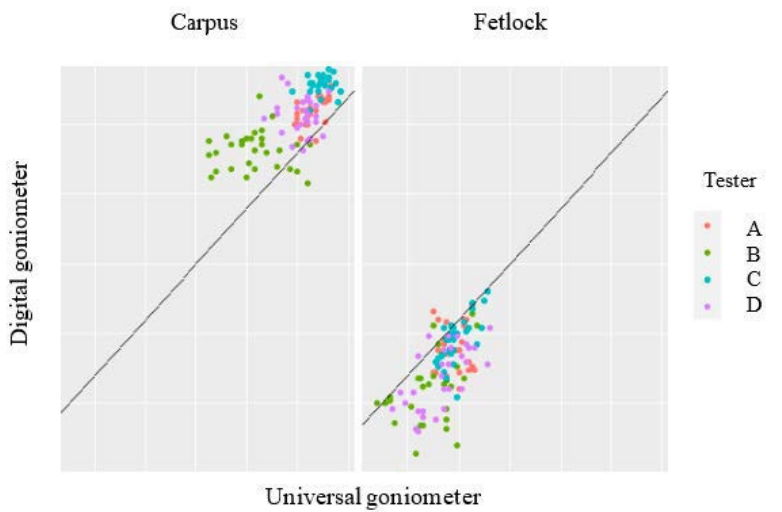
Figure 4. Concurrent validity of the digital goniometer, using the universal goniometer as the reference